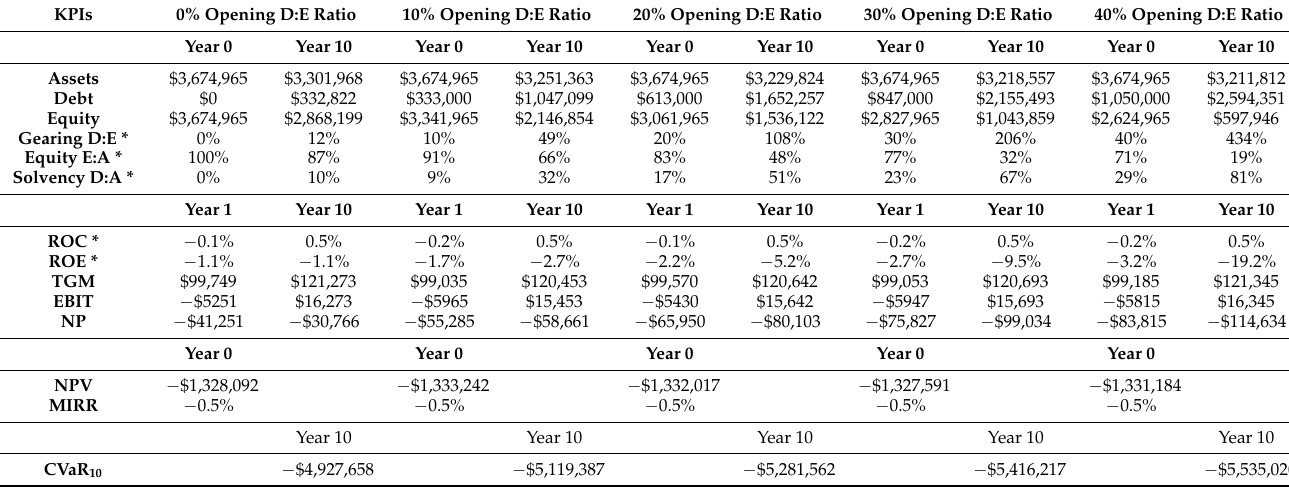
Table 4. Financial Ratios as Median Values for Key Performance Indicators (KPIs) for the five Opening Debt (Debt to Equity ratio)